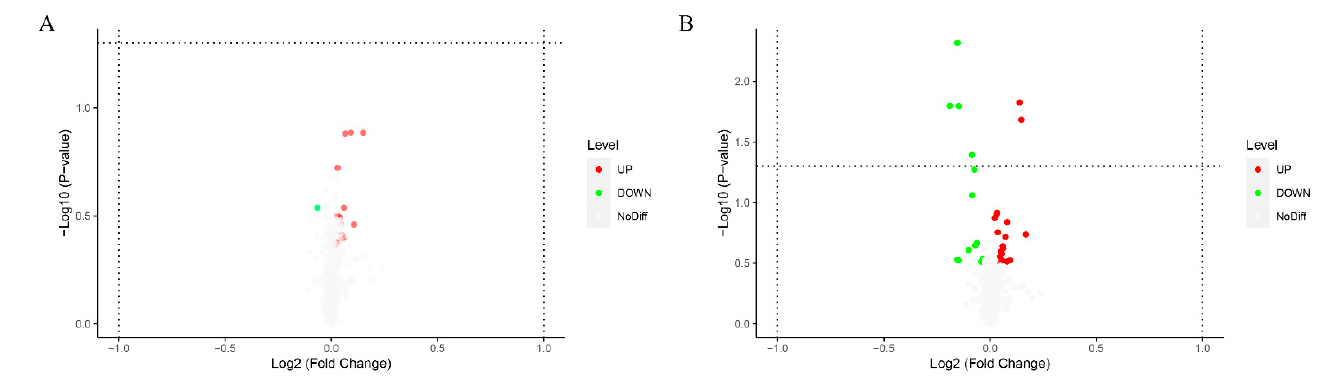
Figure 5. Volcano plot by metabolomics analysis under positive ion mode ( A ) and negative ion mode ( B ), respectively ( n = 6). The red points represent significantly up-regulated metabolites ( p -value < 0.05 and VIP > 1) according to the univariate statistical analysis; the green points represent significantly down-regulated metabolites ( p -value < 0.05 and VIP > 1) and the gray points represent metabolites that did not change.